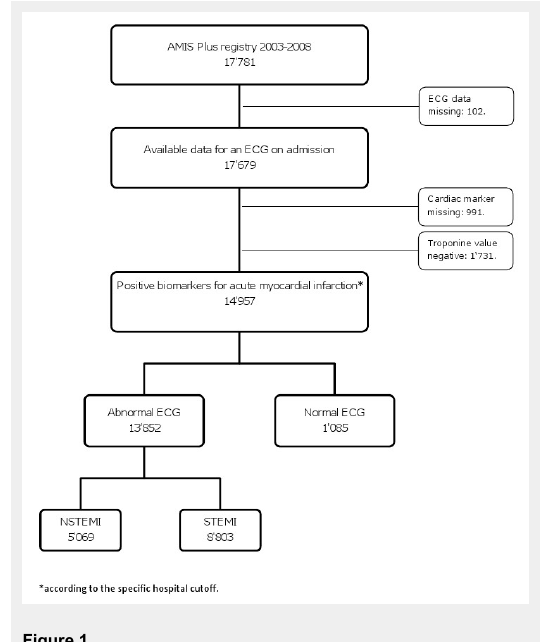
Overview of the patients included in this